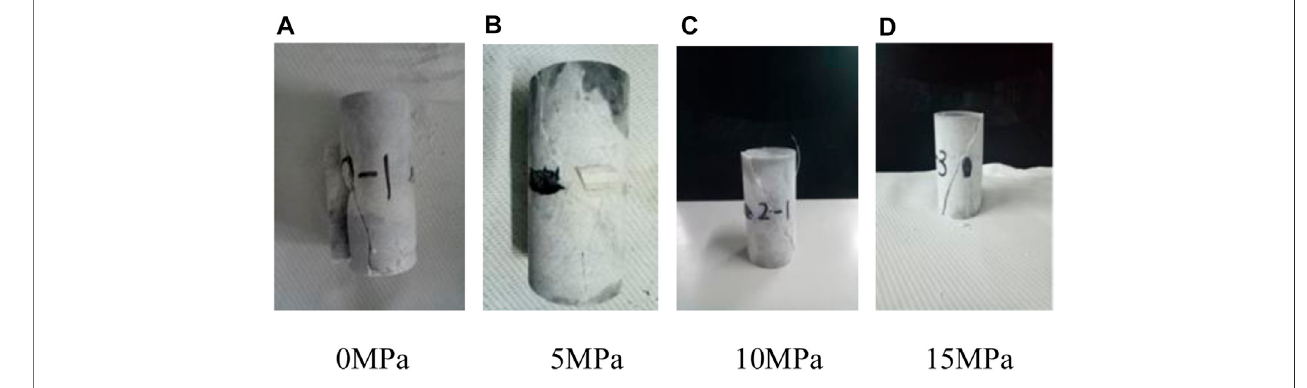
FIGURE 2 | Failure pro fi le of Jinping marble samples.